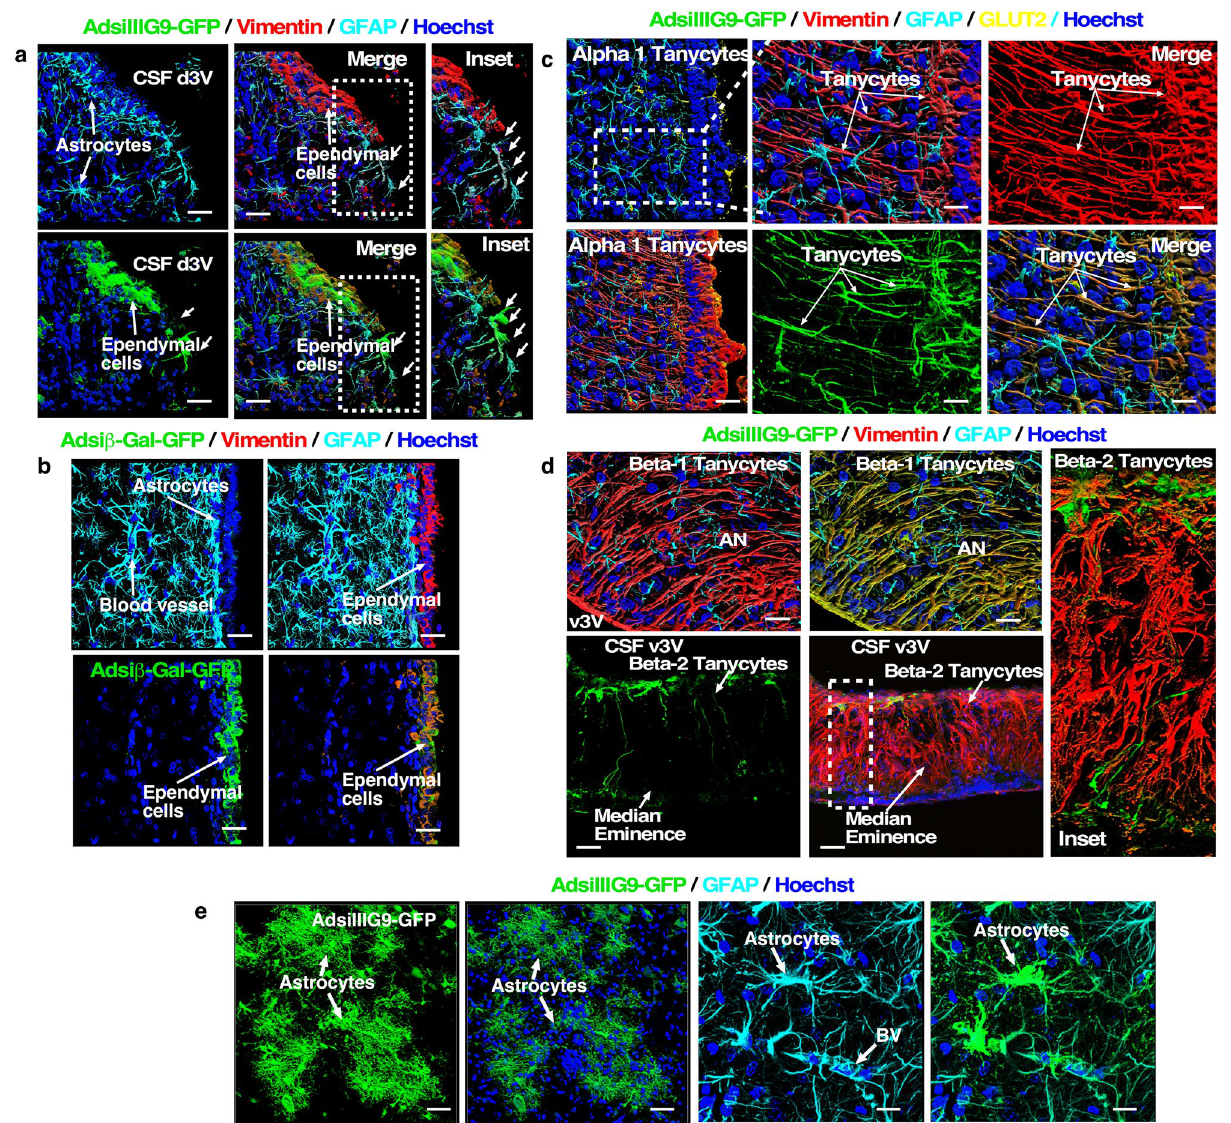
Figure 2. Loss of IIIG9 function in third ventricle ependymal cells induces epithelial denudation but does not alter tanycyte or astrocyte structure. ( a ) Ad-siIIIG9-GFP expression and immunohistochemical analysis for vimentin (red channel) and GFAP (blue-light channel) detection in third ventricle ependymal cells 6 days after Ad-siIIIG9-GFP injection. Confocal Z-stack images were rendered using ZEN software. Ependymal cell denudation was observed (small arrows and insets). ( b ) Ad-siβGal-GFP expression (control) and immunohistochemical analysis for vimentin (red channel) and GFAP (blue-light channel) detection. Ependymal cell denudation was not observed. ( c ) Ad-siIIIG9-GFP expression and immunohistochemistry for vimentin (red channel), GFAP (blue-light channel) and GLUT2 (yellow channel). Tanycytes that were Ad-siIIIG9- GFP/vimentin-positive (brown signal) without structural changes were detected. A normal interrelationship between tanycytes and astrocytes was observed (inset and merged image). ( d ) Ad-siIIIG9-GFP expression and immunohistochemical analysis for vimentin (red channel) and GFAP (blue-light channel) detection. Beta-1 tanycytes that were Ad-siIIIG9-GFP/vimentin-positive (brown signal) without structural changes were detected (upper panels). Ad-siIIIG9-GFP/vimentin-positive cells in the median eminence (green and red channels). Normal cell processes of β2-tanycytes were observed (lower panels and inset). ( e ) Ad-siIIIG9-GFP expression and immunohistochemical analysis for GFAP (blue-light channel) detection in astrocytes from brain tissue. No structural changes were detected. All images are representative of different biologically independent samples. AN arcuate nucleus, BV blood vessel, CSF cerebrospinal fluid, v3V ventral third ventricle, d3V dorsal third ventricle. ( a – e ) n = 3. Scale bars = ( a – d ) 10 μm and ( e ) 15